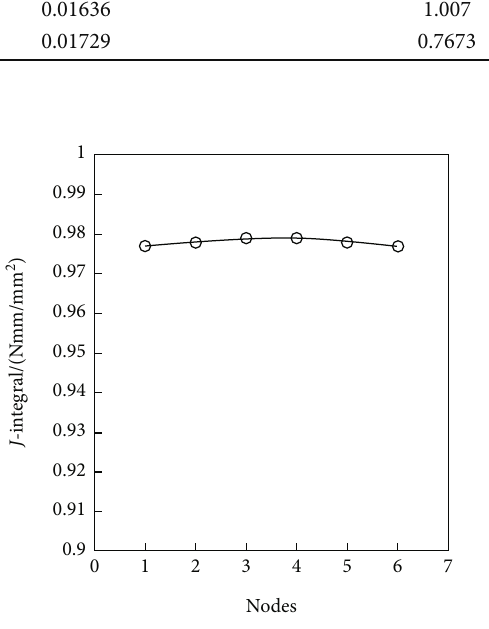
Figure 11: The J -integral of the crack initiation (normal temperature). Table 3: Mechanical properties of the new cast propellant and unilateral crack